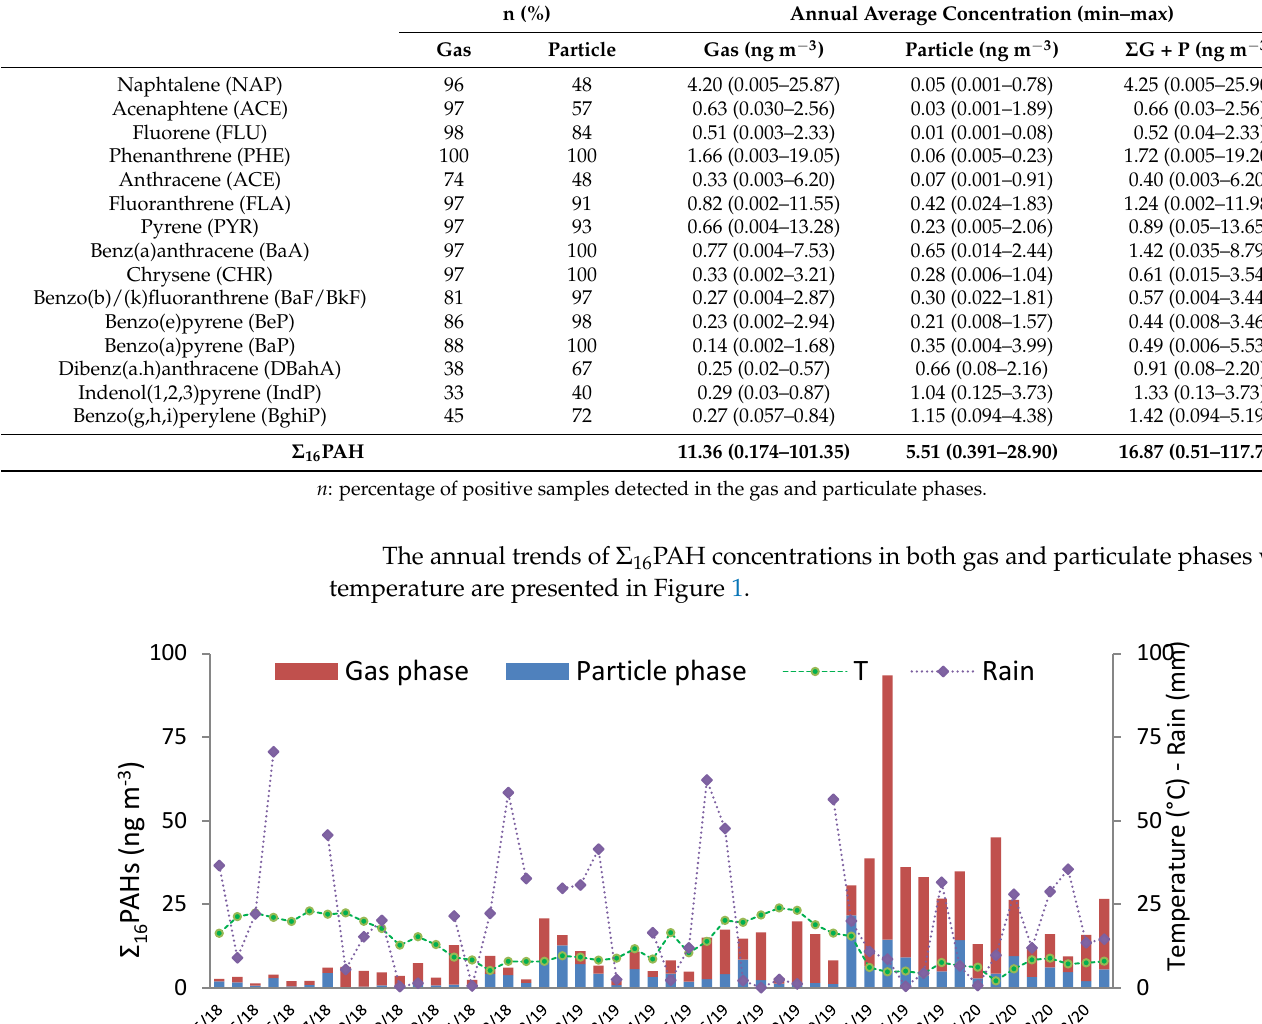
Table 1. Annual mean concentrations of individual polycyclic aromatic hydrocarbons (PAHs) quantified in gas and particulate phases. n (%)